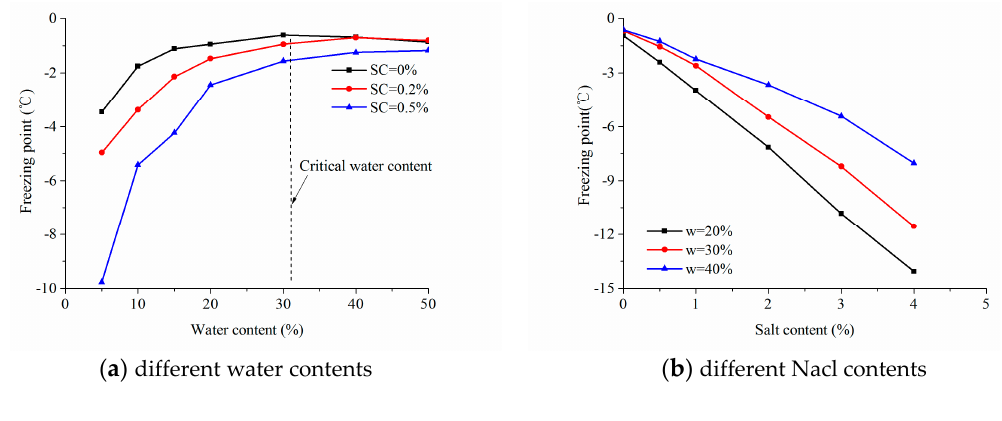
Figure 5. Influence of water content and Nacl content on the freeing temperature.